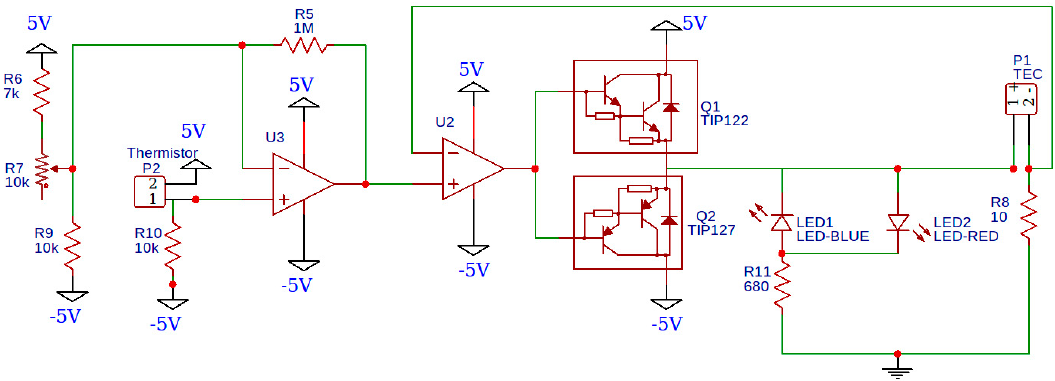
Figure 3. The temperature controller for the SOA and the laser. The circuit is the same since the maximum thermo-electric cooler (TEC) current is set below the smaller maximum rated current of both components. The circuit is designed to work with a dual + 5V and − 5V linear power supply. The operational amplifier is an LM358 double amplifier package.